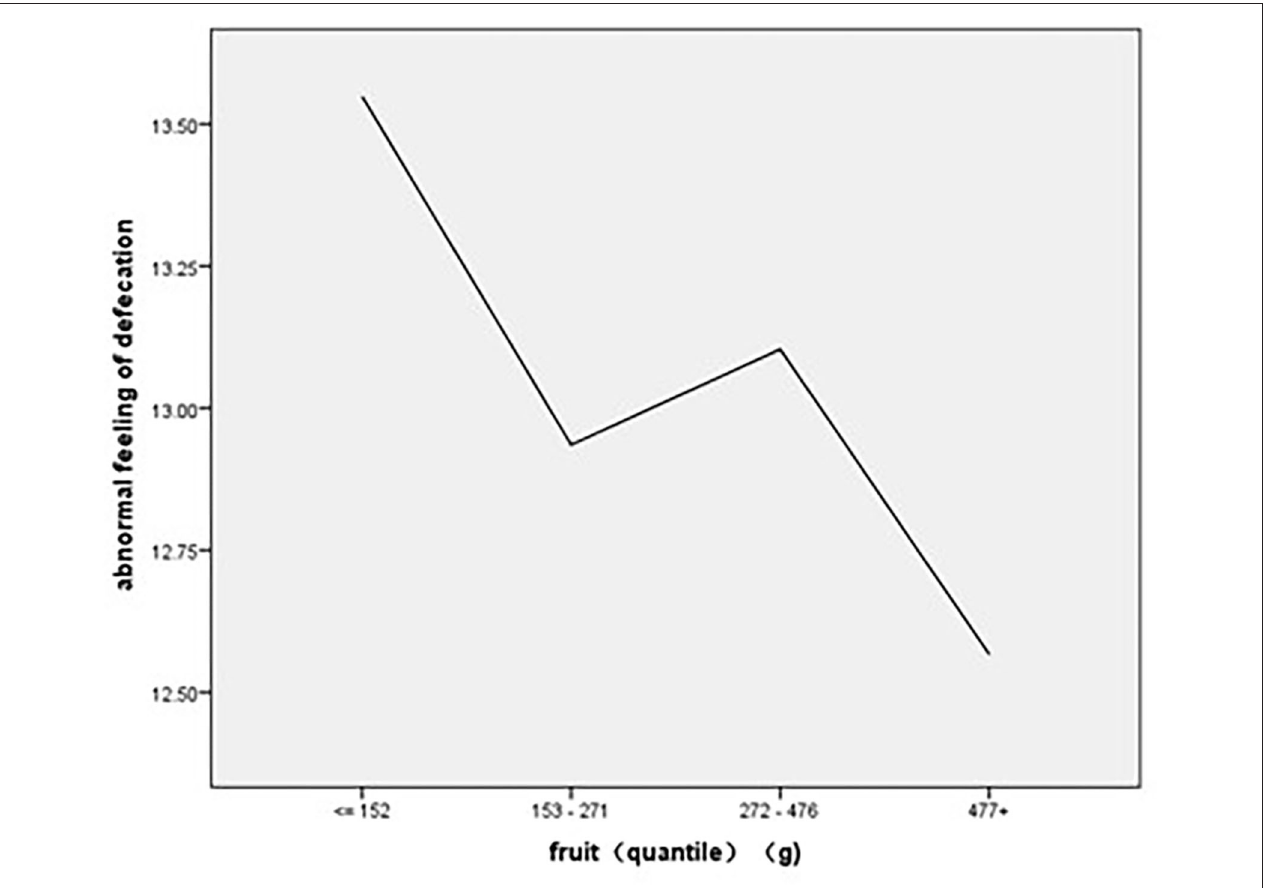
FIGURE 6 | The association of stratified quintiles of consumption of fruits with abnormal feeling of